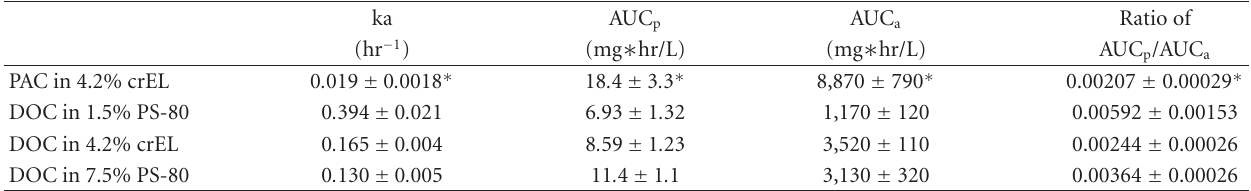
Figure 8: Influence of PS-80 on the anticancer e ff ect of docetaxel (1mg/kg) in AH130 tumor-bearing rats. AH130 tumor-bearing rats were intraperitoneally administered 1 mg/kg of docetaxel in a volume of 20 mL of 1.5% or 7.5% PS-80 on day 0. N = 6. Table 3: Pharmacokinetic parameters of paclitaxel (PAC) and docetaxel (DOC) in plasma and ascitic fluid after an i.p. administration of drugs in crEL or PS-80 to nontumor rats